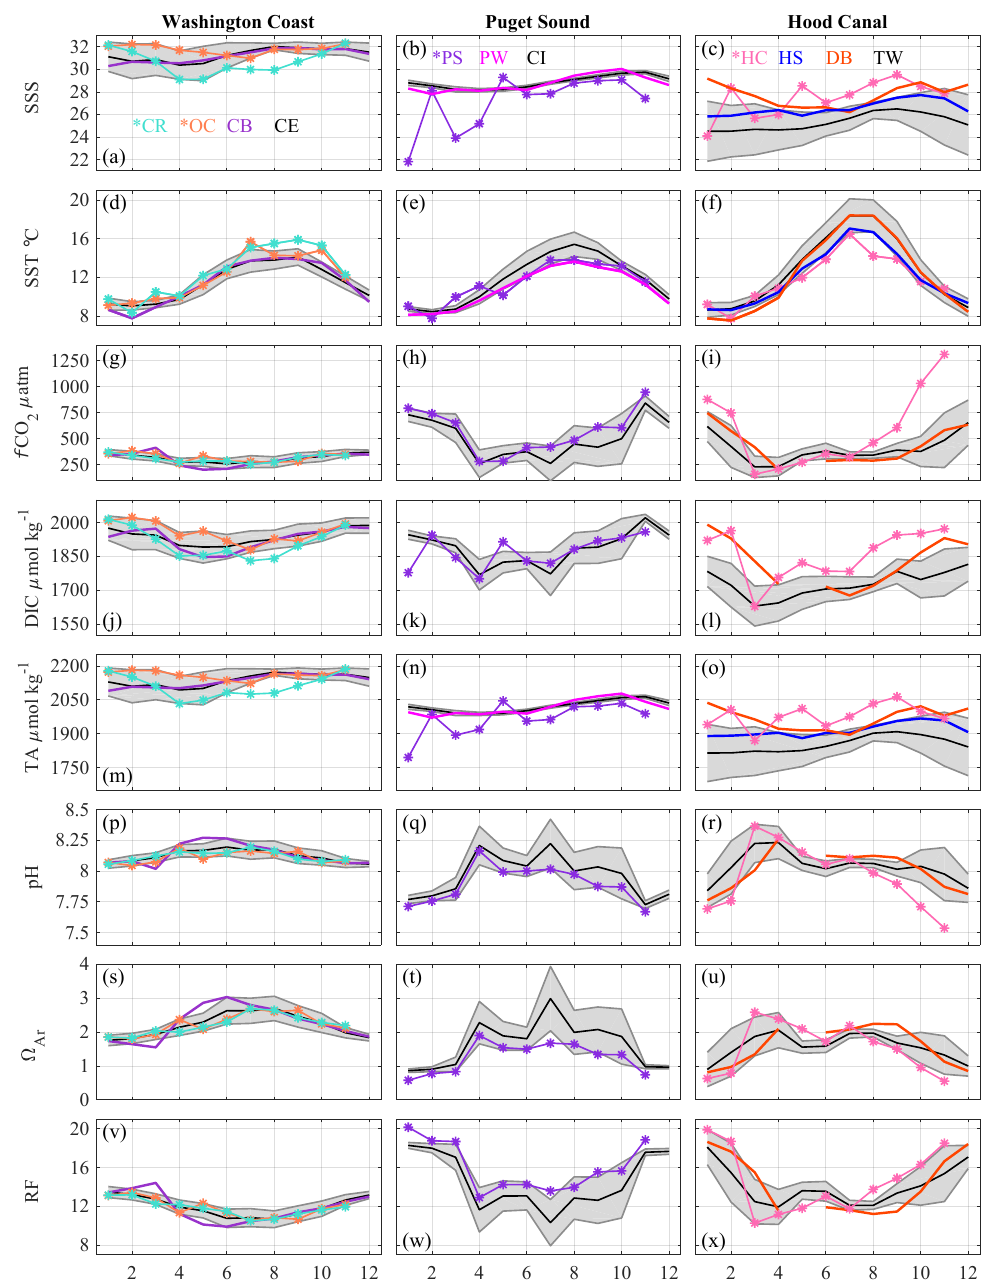
Figure 6. Seasonal cycles of (a) – (c) SSS, (d) – (f) SST, (g) – (i) f CO 2 , (j) – (l) DIC, (m) – (o) TA, (p) – (r) pH T , (s) – (u) (cid:127) Ar , and (v) – (x) RF for regions and moorings located along the outer Washington Coast, in Puget Sound, and in Hood Canal. Asterisks are used for the regions. Black lines with gray shading highlight data from one mooring within each domain (see figure keys in subplots a to c ). Gray shading shows the average range of variability about the mean during each month (i.e., average standard deviation across years derived from variance estimates). See also Appendix D